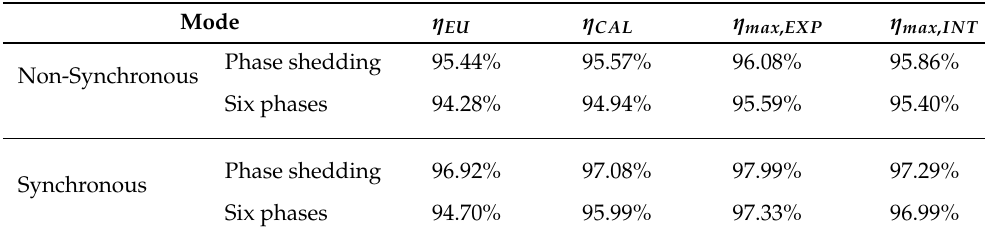
Table 7. European, Californian, maximum experimental, and maximum interpolated efficiencies computed for both non-synchronous and synchronous operating